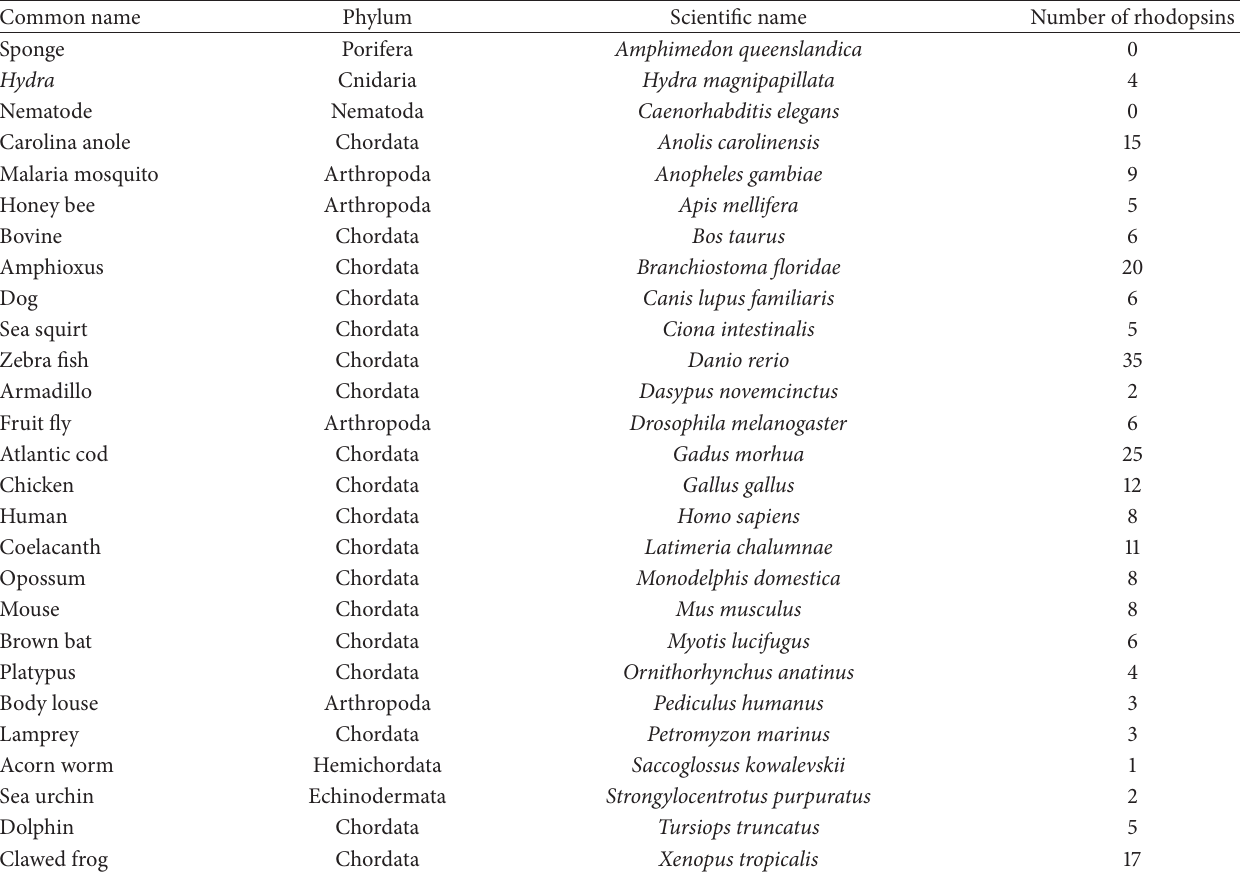
Table 2: The number of rhodopsin genes in each metazoan